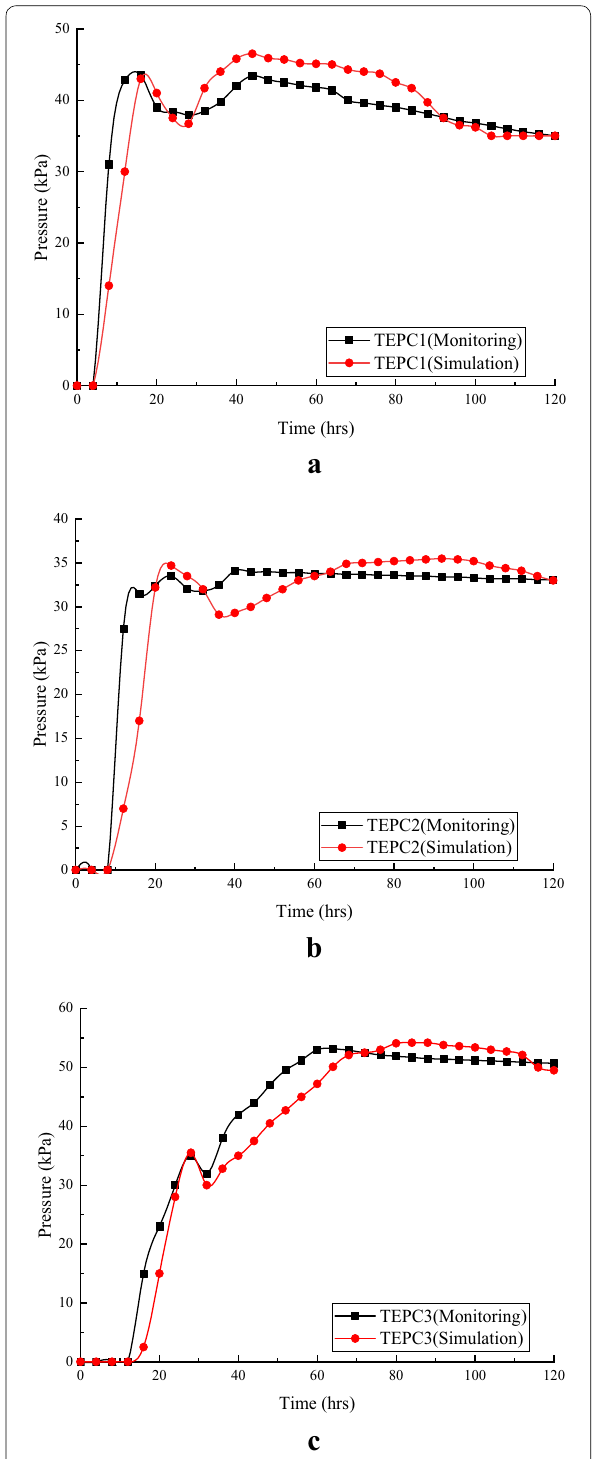
Fig. 9 Comparison between the simulated and measured barricade pressure corresponding to the monitoring sensors of TEPC1 ( a ), TEPC2 ( b ) and TEPC3 ( c